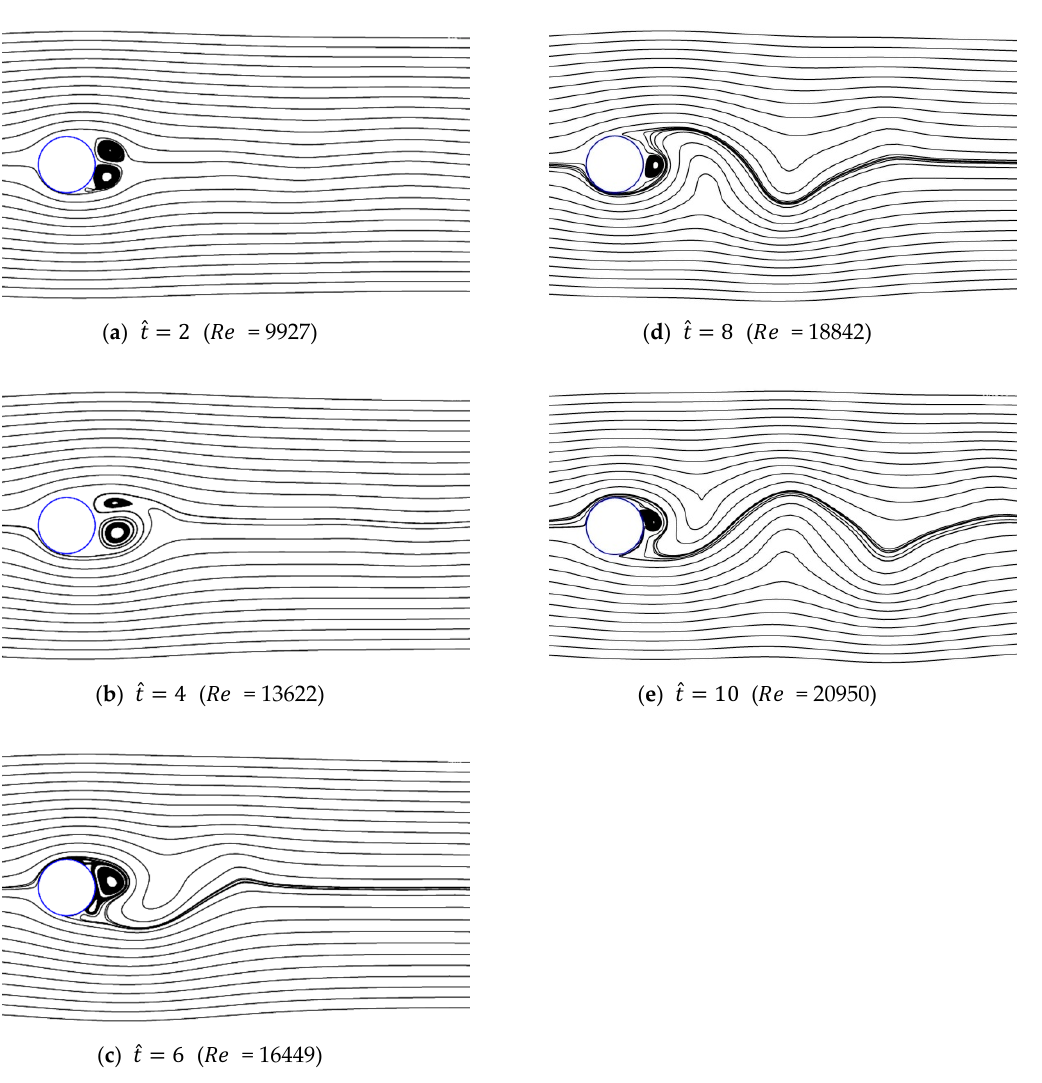
Figure 25. Streamlines around circular cylinder ( a / g = 1, Re 0 = 1000 )